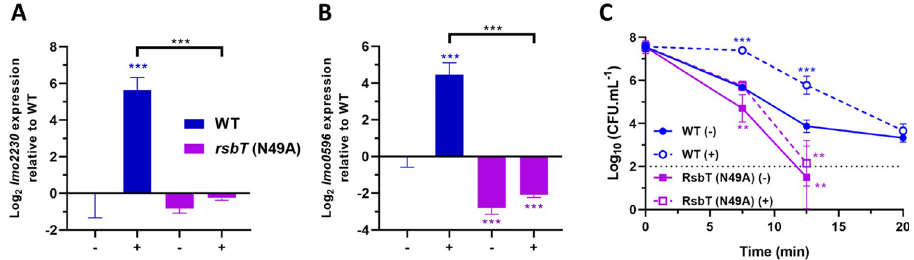
Fig 6. The kinase activity of RsbT is essential for acid sensing by the stressosome. Expression of σ B -dependent genes (A) lmo2230 and (B) lmo0596 , obtained from mid-log phase cultures of wild type and rsbT (N49A) strains untreated (-) and treated (+) for 15 min in pH 5.0 at 37˚C. Gene expression is represented as Log 2 relative gene expression. (C) Acid challenge of mid-log phase cultures treated in pH 5.0 for 15 min at 37˚C, as previously described in Fig 2D. Survival data is expressed as Log 10 (CFU.mL -1 ). Statistical analysis was performed using a paired Student’s t - test relative to the wild type untreated after 15 min, for RT-qPCR data, and untreated wild type at time 0 min, for acid challenge data ( � , P value of < 0.05; �� , P value of < 0.01; ��� , P value of <